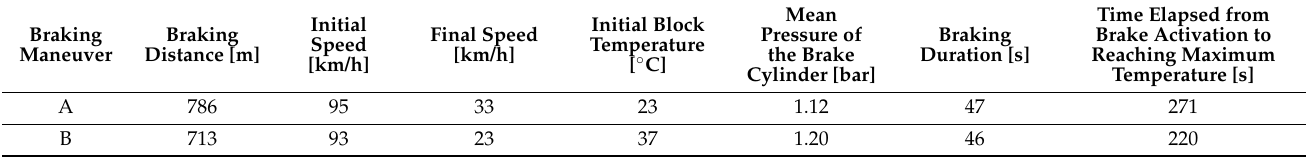
Figure 3. Mesh of the brake pad obtained in Ansys ADPL. Table 2. Input data for the finite element (FE)